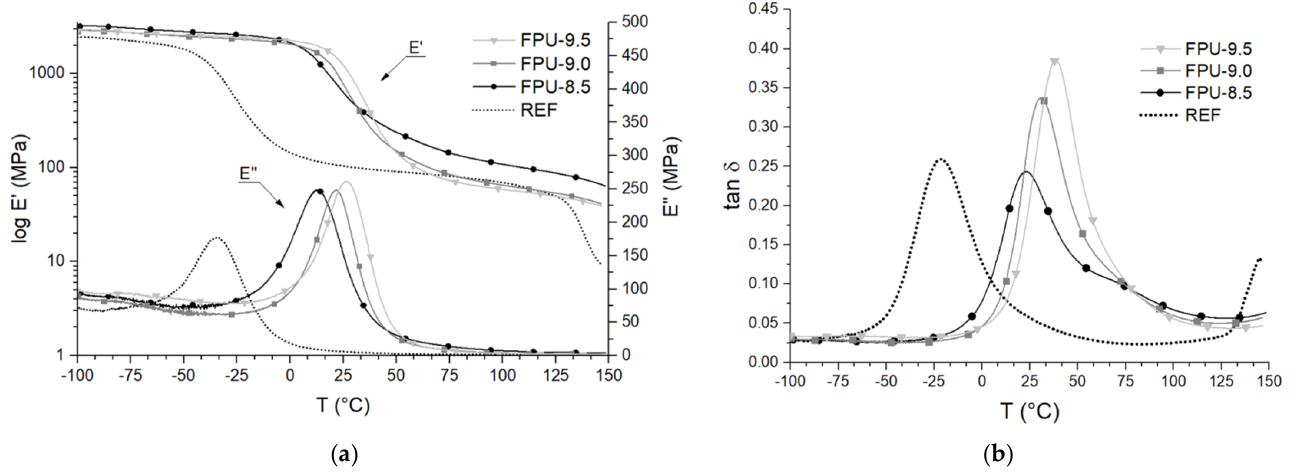
Figure 4. DTMA results: ( a ) the logarithm of storage modulus (log E’) and loss modulus (E”); ( b ) and the damping factor (tan δ) as a function of the temperature (T) of the obtained polyurethanes.